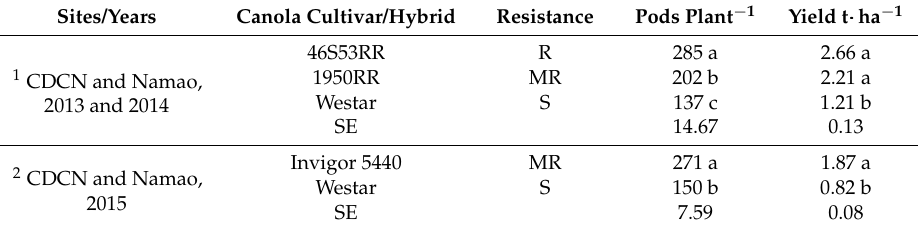
1 Data are the means of four replications × three site-years; 2 Data are the means of four replications × two sites. Means in a column followed by the same letter are not significantly different according to the Tukey-Kramer test ( p ≤ 0.05).